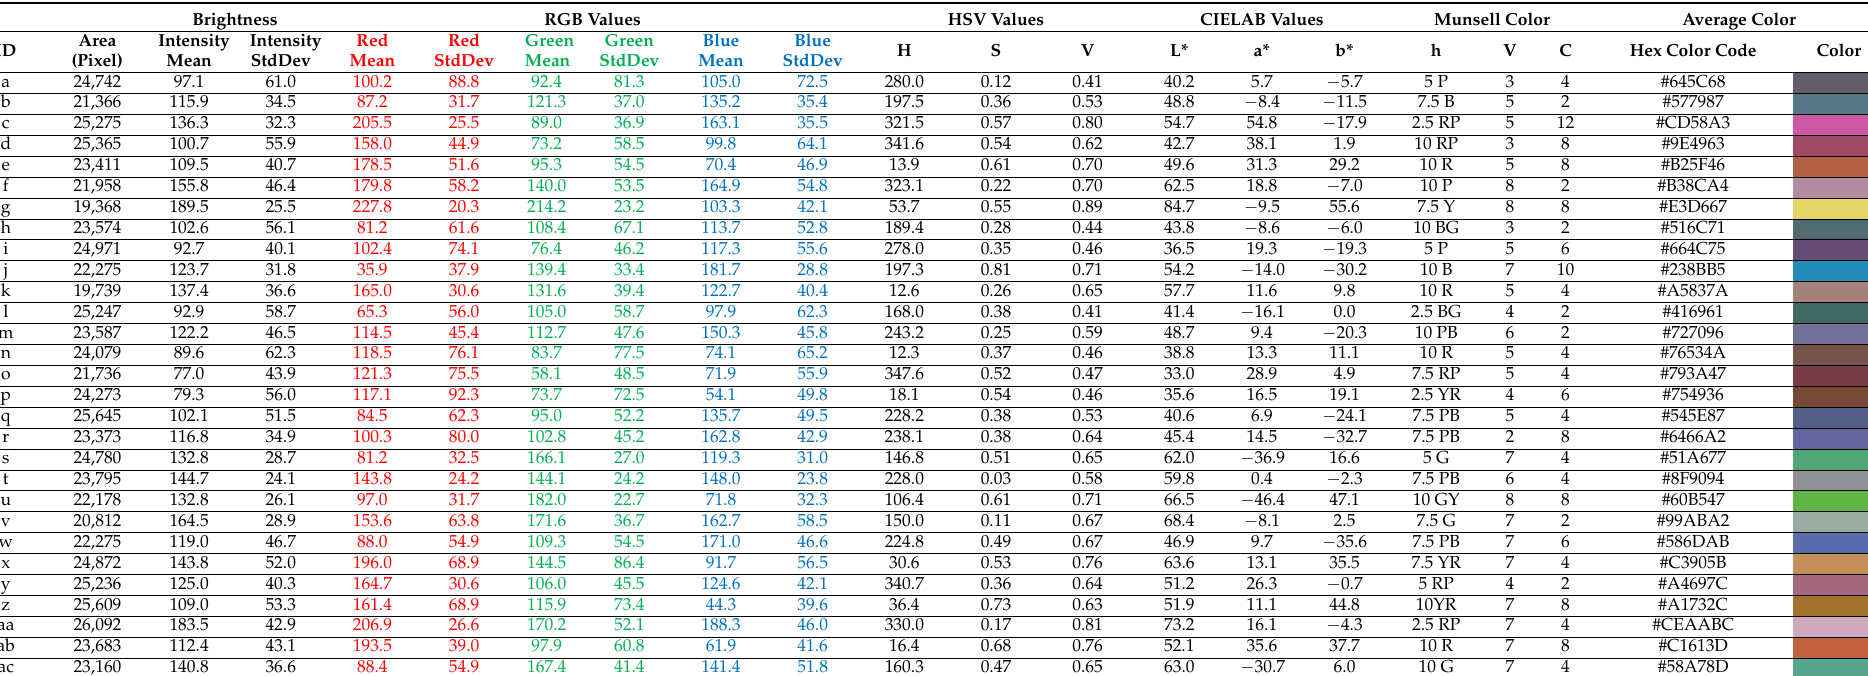
Table 1. Statistical summary of color information on twenty-eight dyed T-shirts. (Mean and standard deviation of brightness and RGB values, as well as average HSV (for hue, saturation, value) values, CIE L*a*b* values, Munsell color values, hex color codes for average color of individual dyed T-shirts). Intensity means and standard deviations of red, green and blue channels were shown in representing